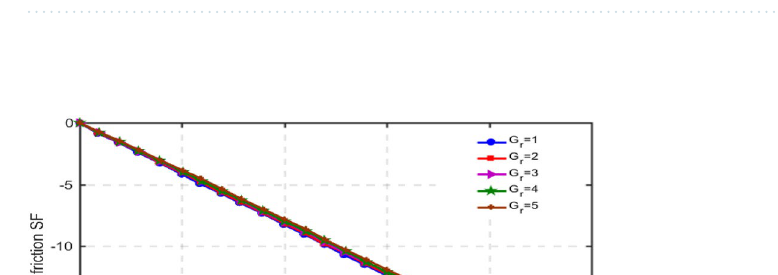
Figure 18. Skin-friction for different values of Ha.